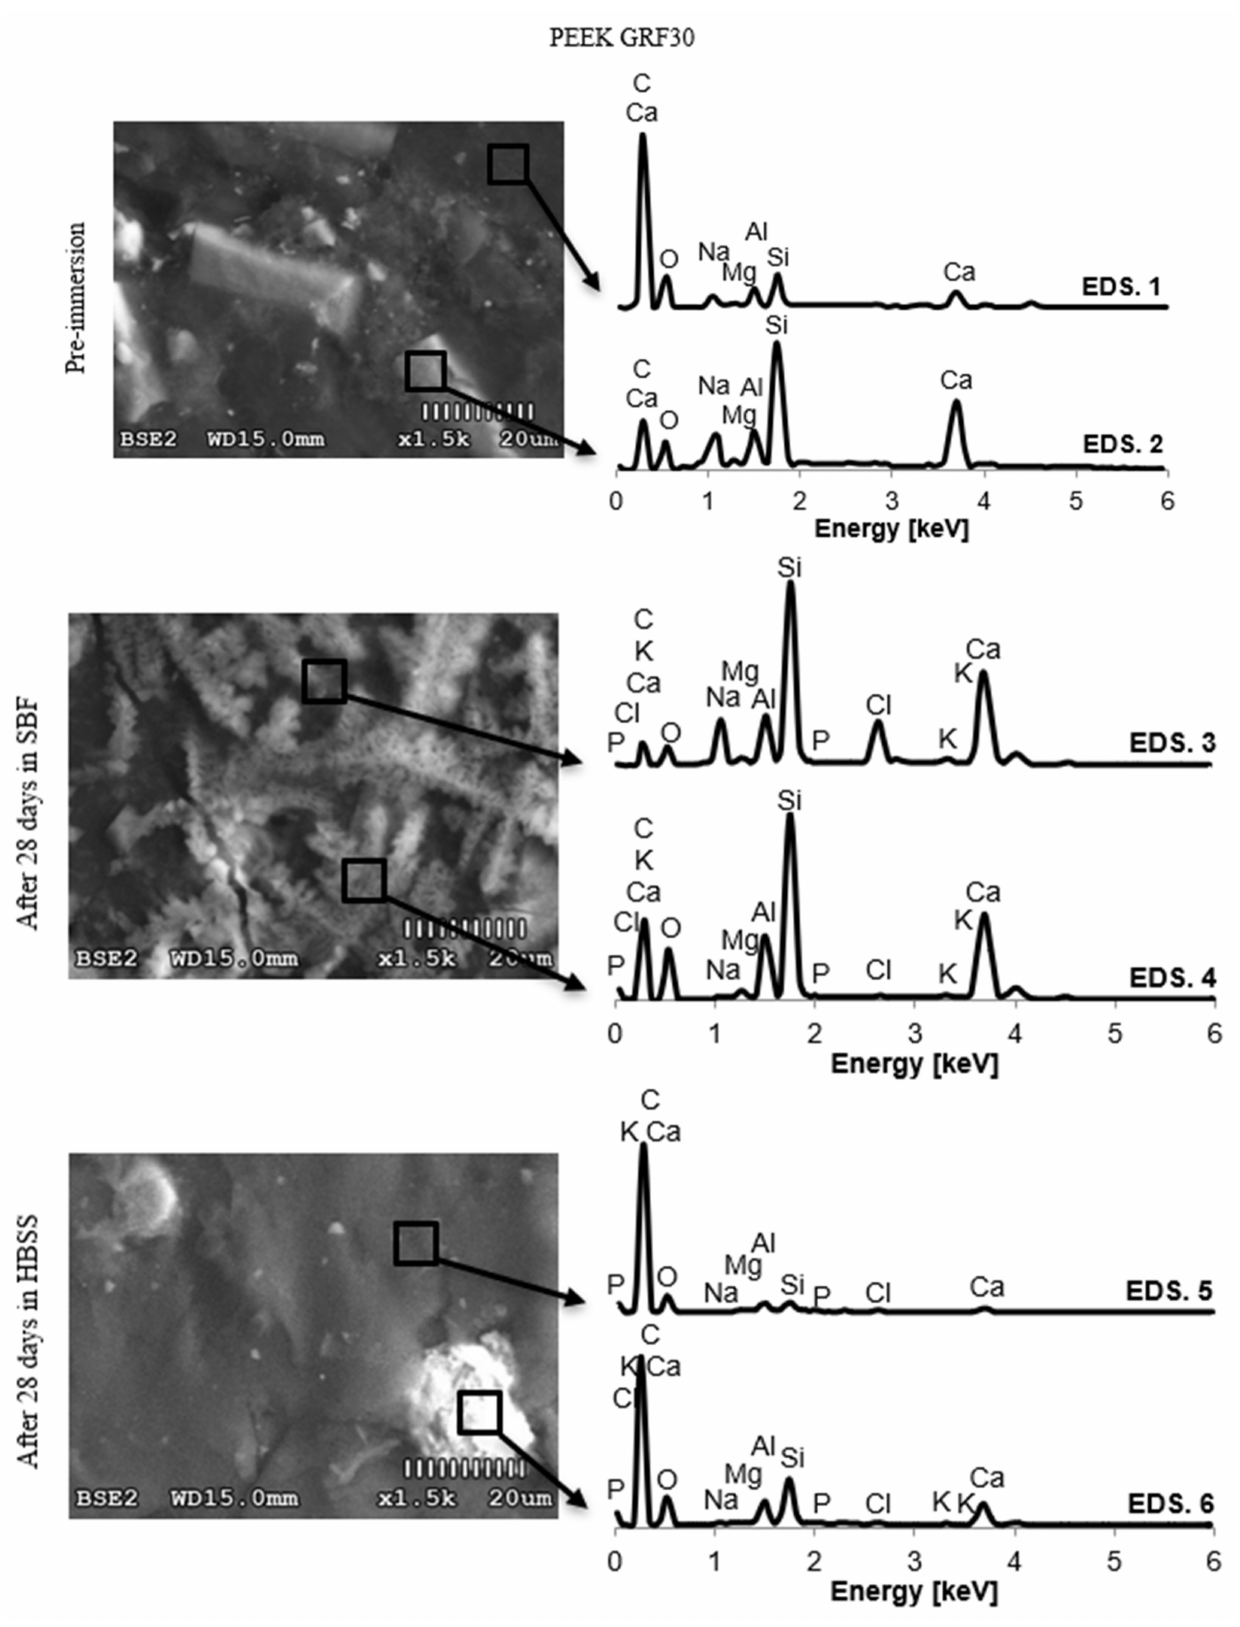
Figure 5. Spectrum of Energy Dispersive Spectroscopy (EDS) of PEEK GRF30 before and after 28 days of material samples immersion in SBF and